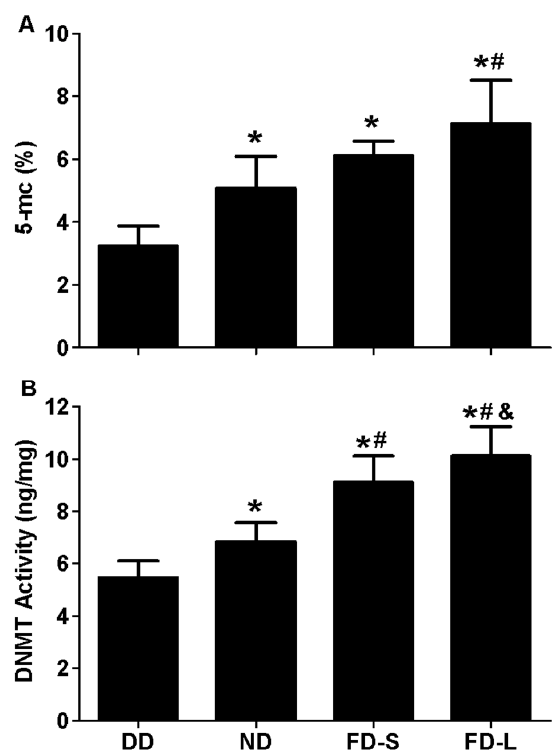
Figure 4. Maternal folic acid supplementation increased global DNA methylation level and DNMT activity in offspring brain. Dams were fed as described in Figure 1. ( A ) Global DNA methylation level (5-mC level) in brain tissue of offspring; ( B ) DNMT activity in brain tissue of offspring. * p < 0.05 compared with DD group. # p < 0.05 compared with ND group. & p < 0.05 compared with FD-S group. Data are expressed as mean ± SD for n = 10 pups/group (same pups as Figure 2).